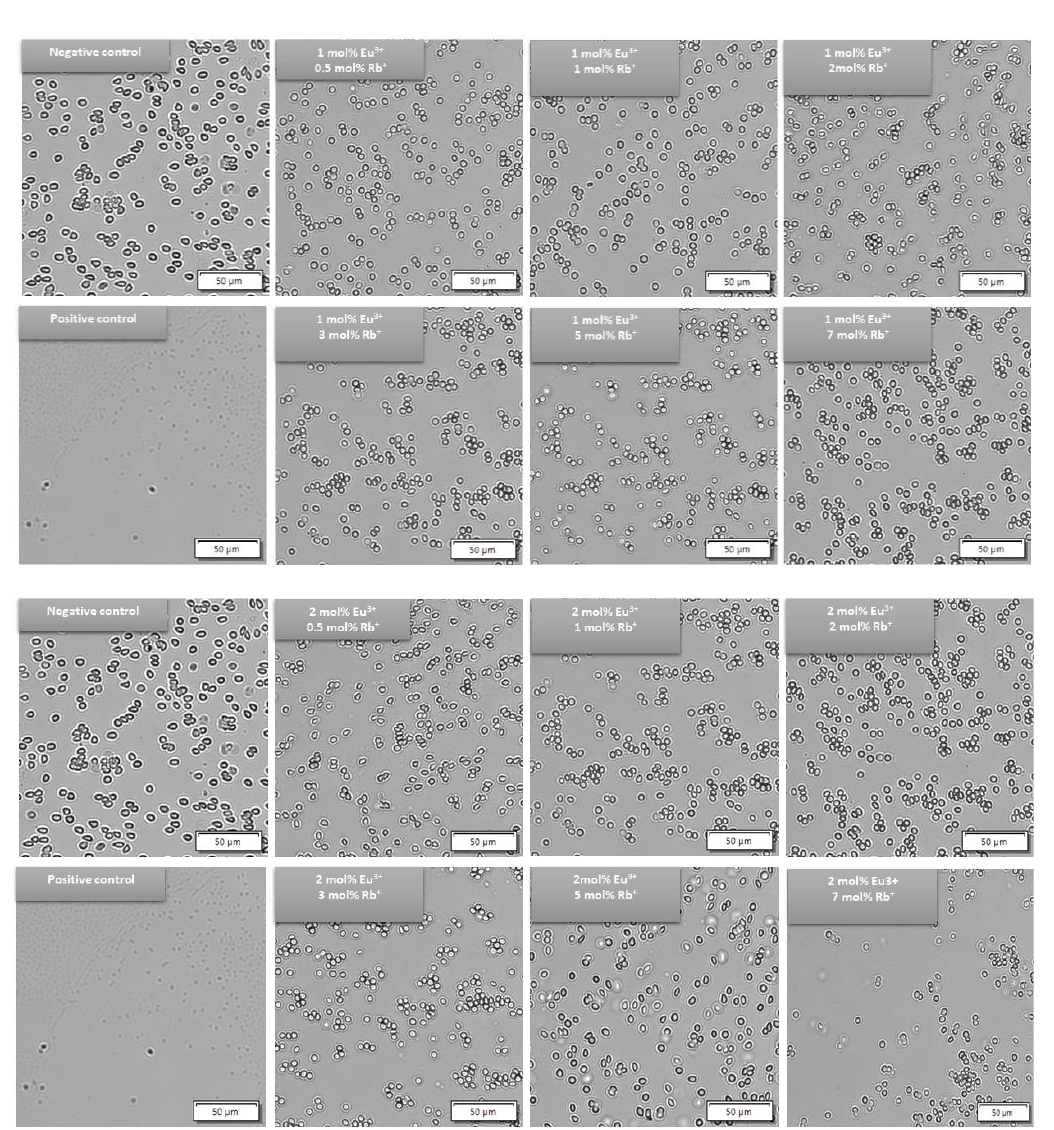
Figure 12. Red blood cell morphology after 24 h of incubation both series of compounds Ca 10 − (0.1 + x) Eu 0.1 Rb x (PO 4 ) 6 (OH) 2 and Ca 10 − (0.2 + x) Eu 0.2 Rb x (PO 4 ) 6 (OH) 2 , where x = 0.5; 1; 2; 3; 5; 7 mol%) at the final concentration 100µg/mL. The morphology of red blood cells was compared with negative control (PBS buffer) and positive control (1% SDS).